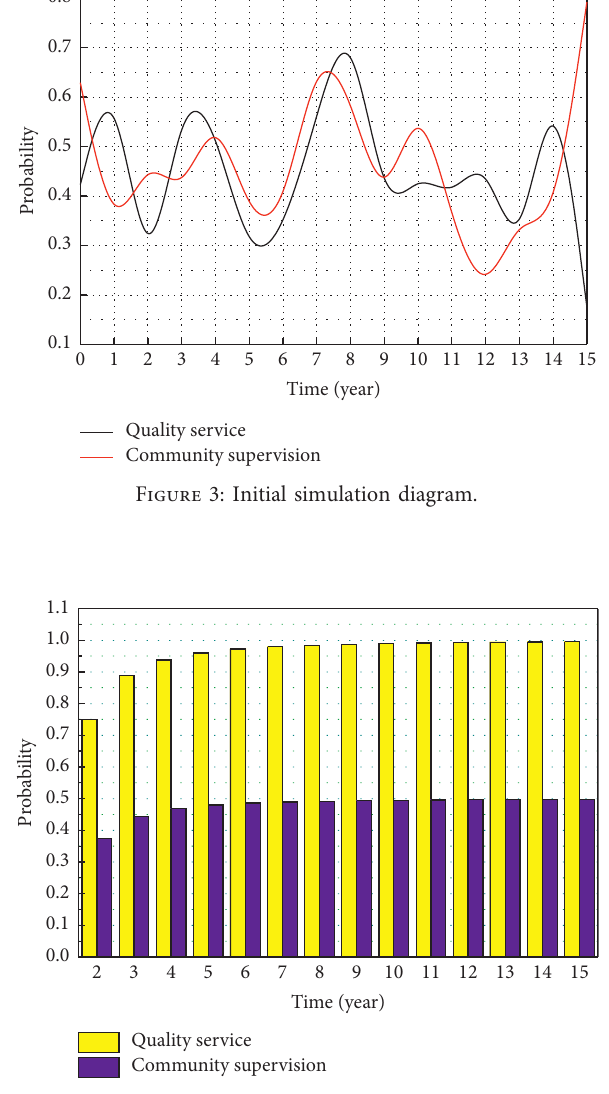
Figure 4: Simulation diagram of the evolution of equilibrium point mutation.